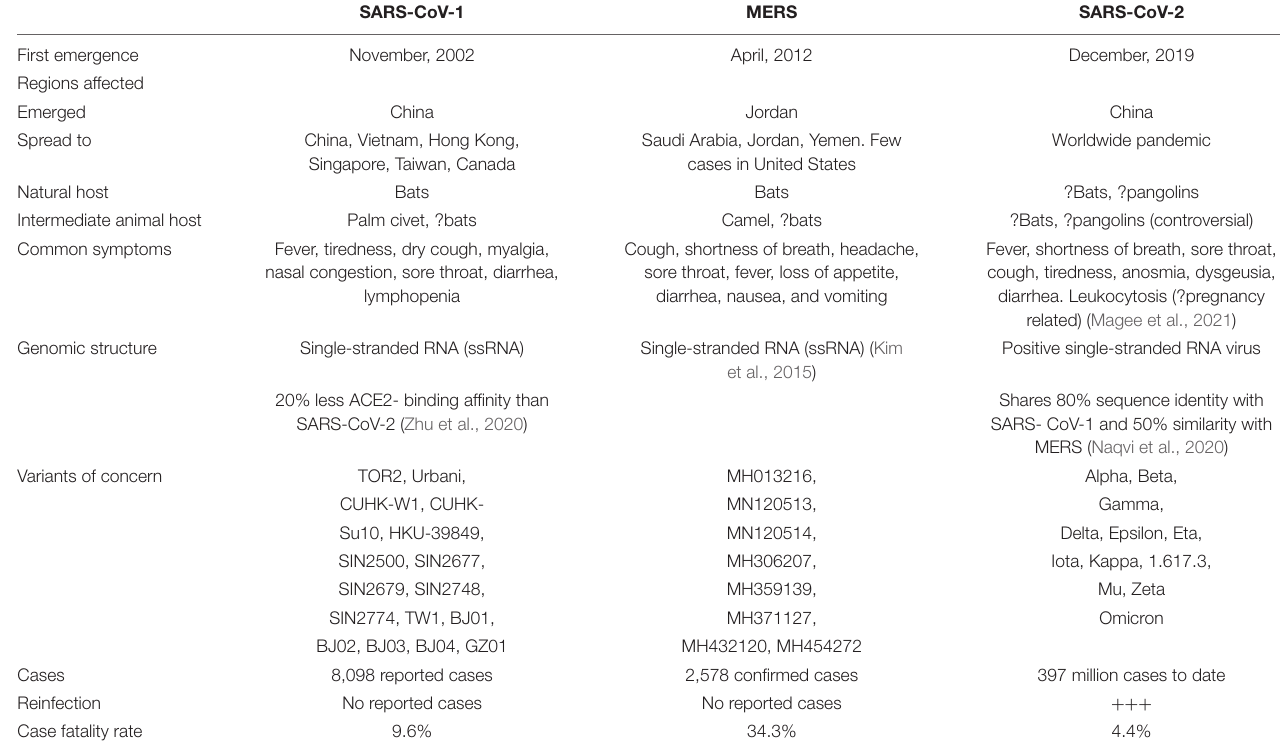
TABLE 1 | Comparison of SARS-CoV-1, MERS, and SARS-CoV-2.